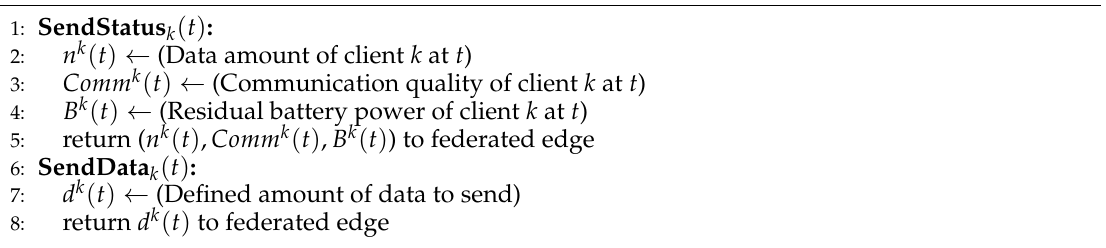
Algorithm 2 Procedure at each client k